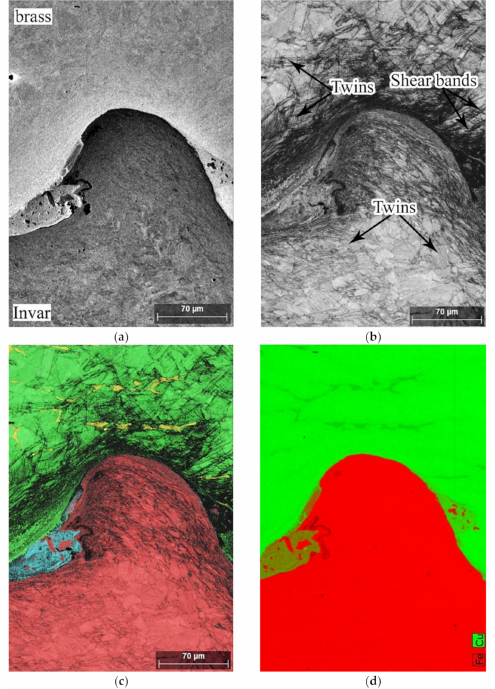
Figure 4. Structure and phase composition of the materials near the interface: ( a – c ) BSD, pattern quality and phase distribution map, respectively. In ( c ), brass (CuZn) is green; Invar (FeNi) is red; the melted zone (Fe–Ni–Cu–Zn) is cyan; and the β (cid:48) -phase (CuZn) is yellow. ( d ) Element distribution map of Fe +